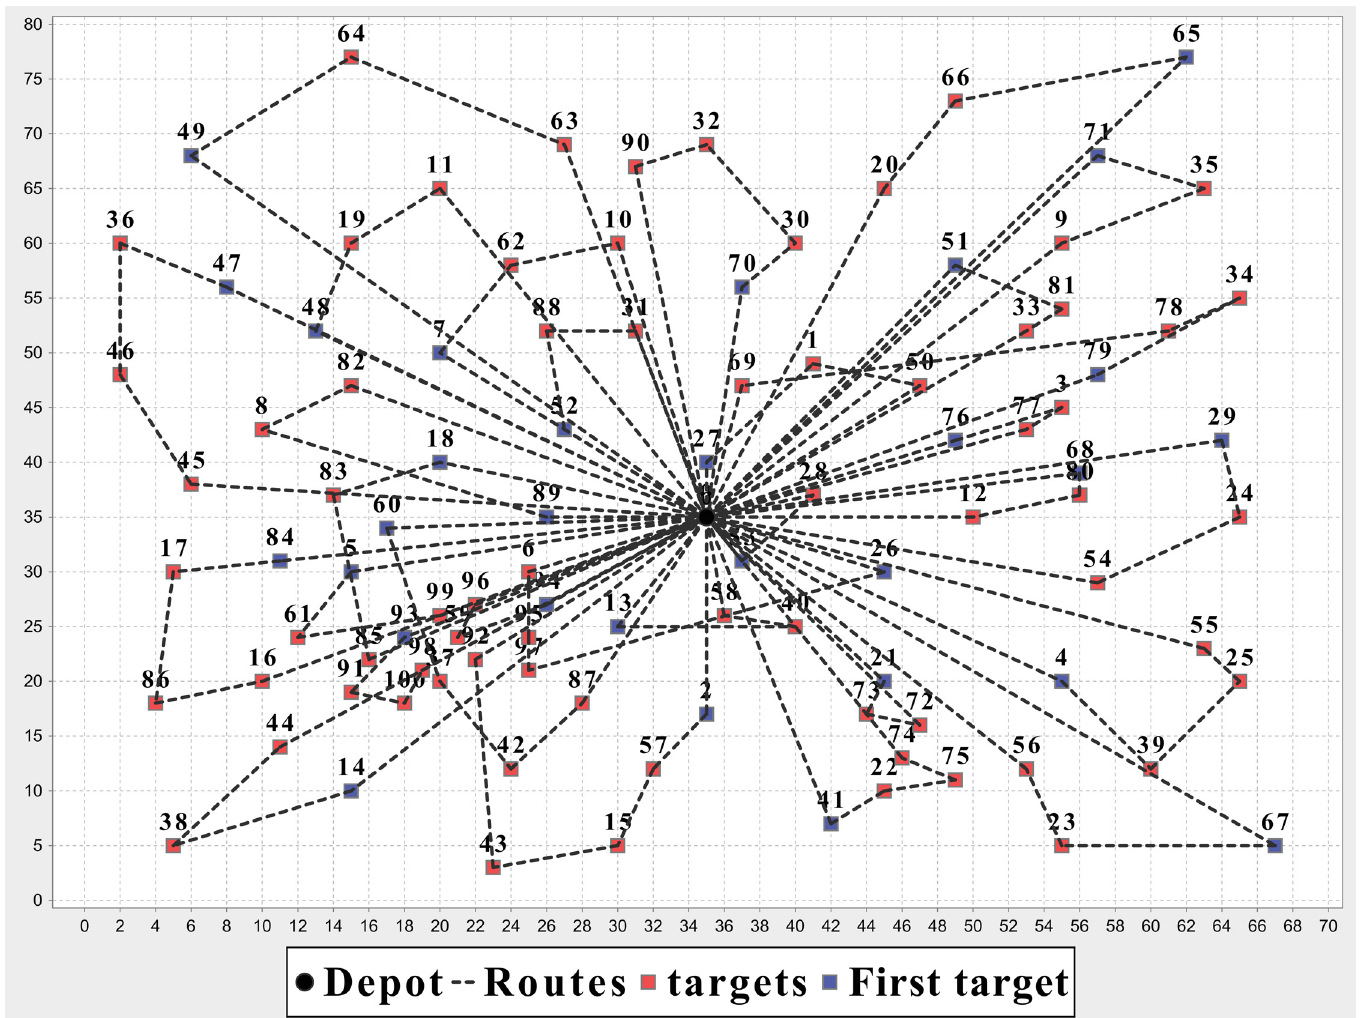
Fig 13. Optimization results of MOEA/D-N-UAV on instance E-n101-k14.